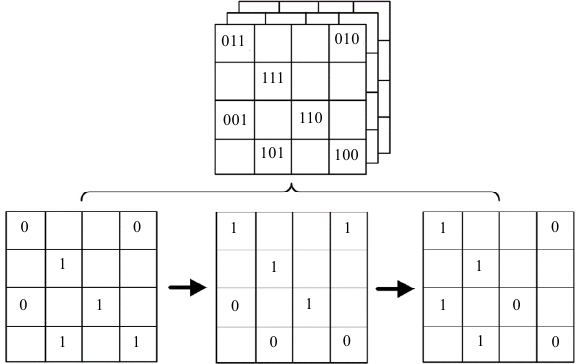
Fig. 5 Representation of numerical matrices independently. The elements in the octal Gaussian random matrix are expressed in binary, and then three measurement matrices are separated from the high to the low, which are sequentially